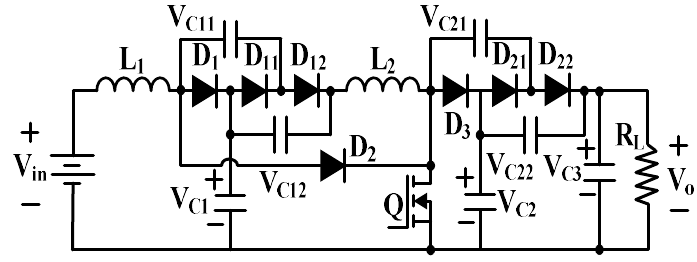
Figure 17. Two-stage cascade boost converter.